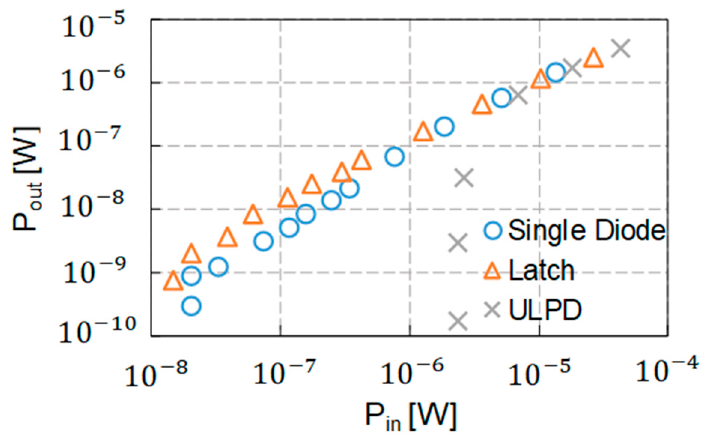
Figure 6. Comparison between rectifier candidates.